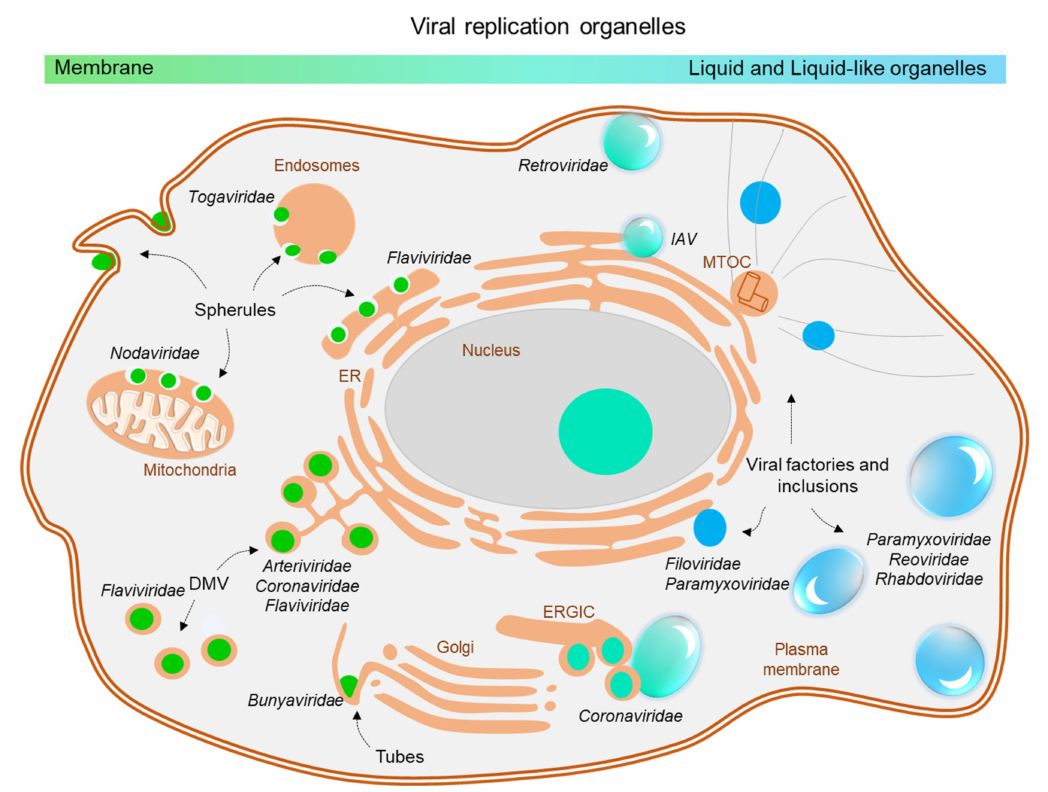
Figure 1. Overview on viral replication organelles in cells upon infection with different RNA viruses. Viral replication compartments associated with membranes are depicted in green, membrane-less compartments are indicated in blue. Those with liquid phase properties are depicted as droplets. DMV, double membrane vesicles. ER, endoplasmatic reticulum. IAV, Influenza A virus. MTOC, microtubule organizing center, ERGIC, endoplasmtic-reticulum–Golgi intermediate